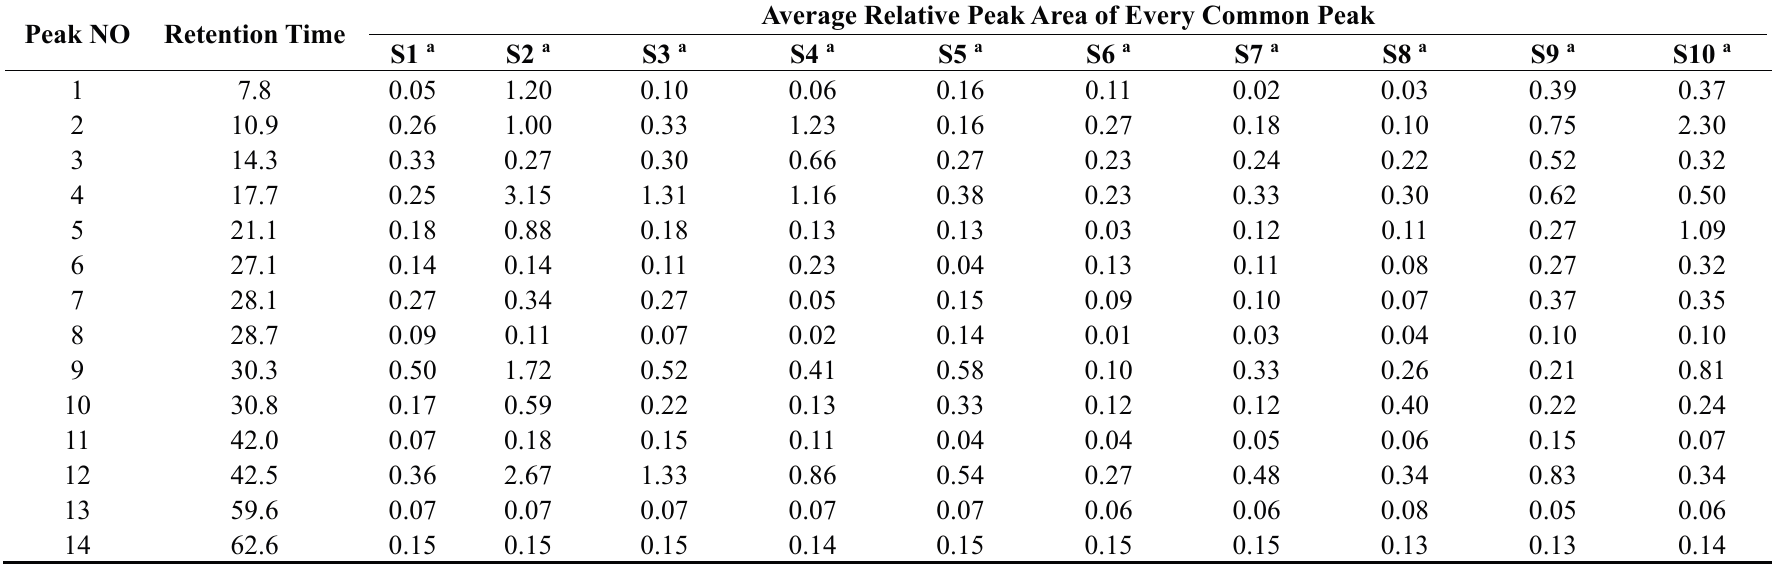
Table 1. The average retention time and relative peak area of every common characteristic